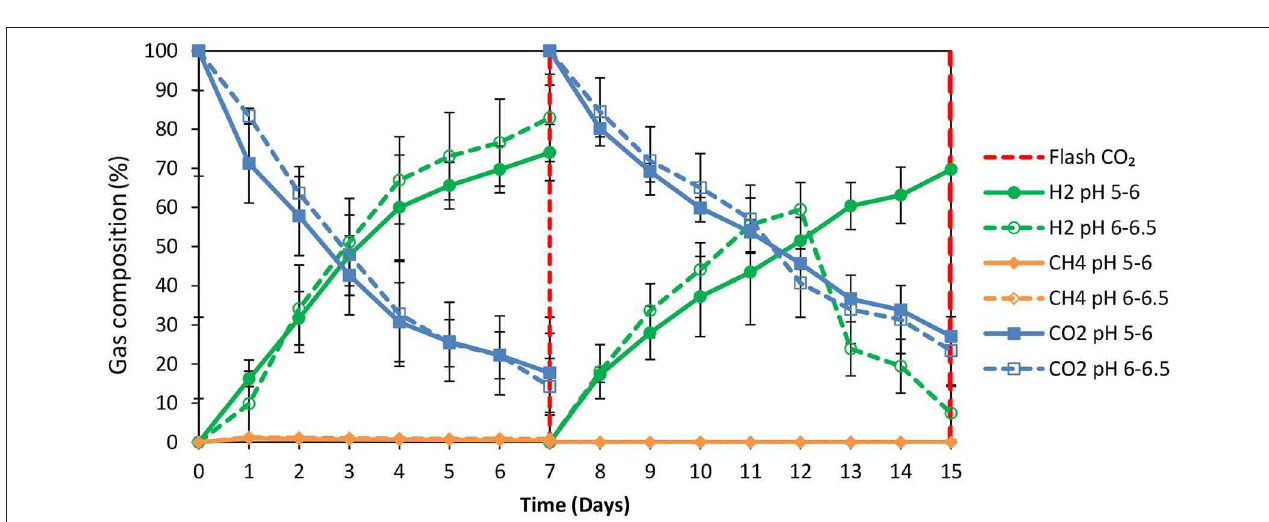
FIGURE 5 | Gas composition (%) over time for anaerobic granular sludge with 50mM BES, 100 g/L ZVI and operation at pH 5–6 and pH 6–6.5, respectively.